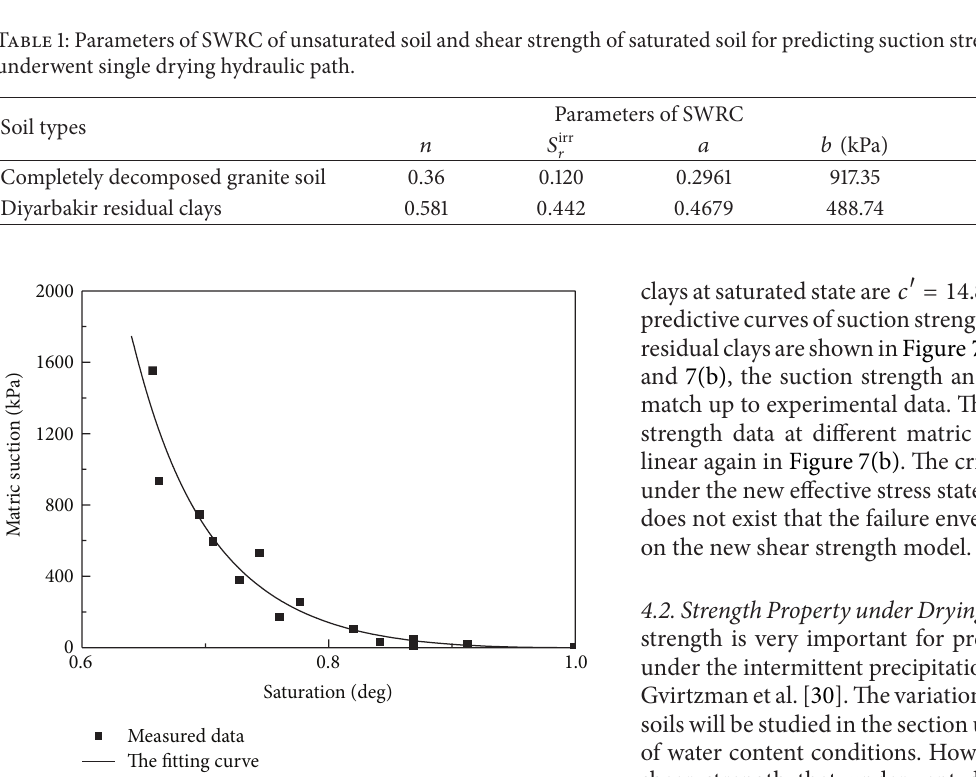
Figure 6: The fitting tested curve of SWRC for Diyarbakir residual clays (measured data from Kayadelen et al.